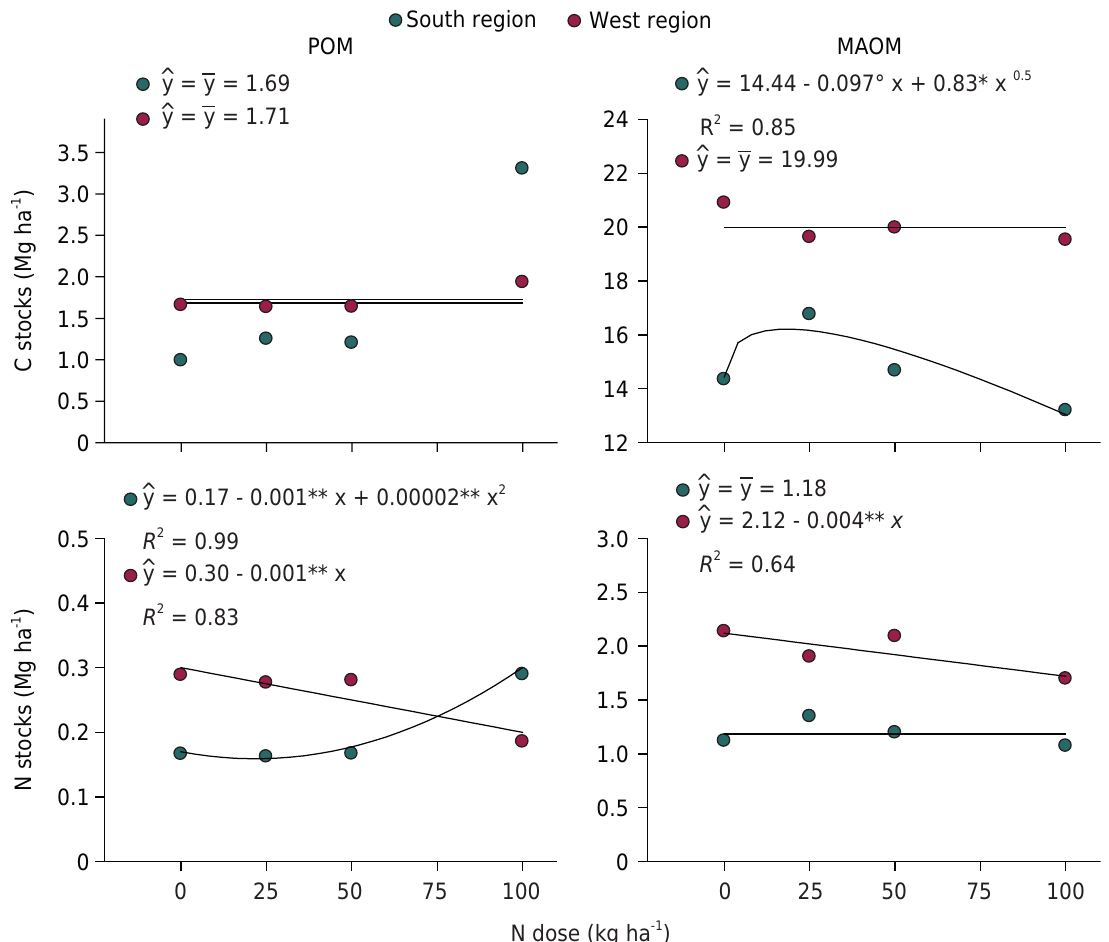
Figure 2. Carbon (C) and nitrogen (N) stocks of particulate organic matter (POM) and mineral-associated soil organic matter (MAOM) as a function of N fertilization rates. °, * , and ** indicate equation parameters significant at 10, 5, and 1 %,